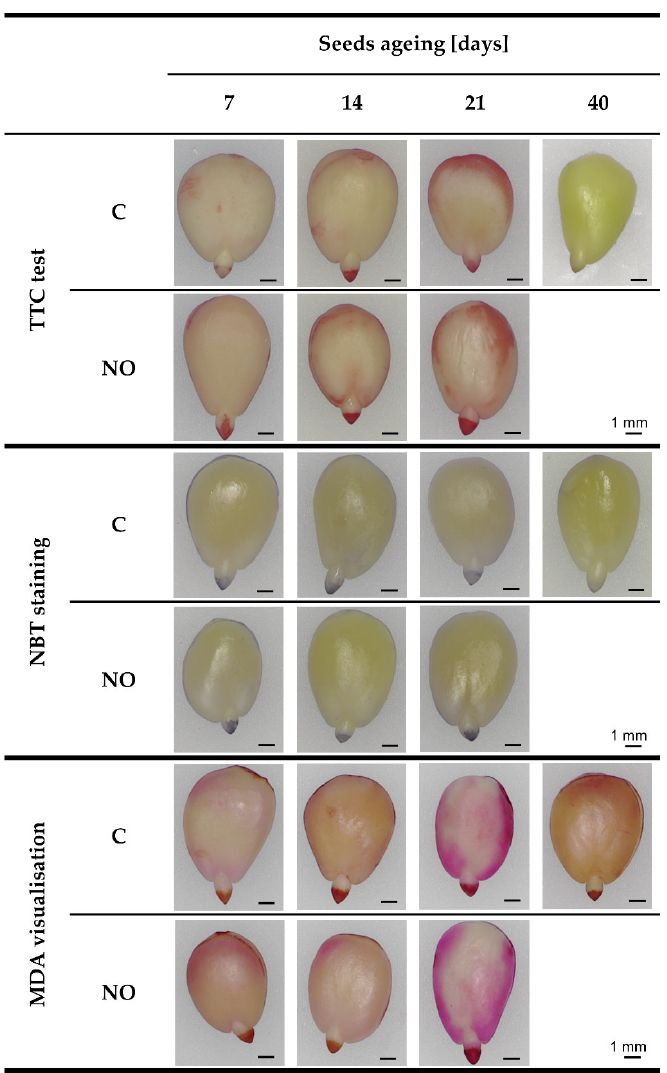
Figure 5. Visualization of staining of apple embryos isolated from seeds subjected to accelerated ageing for 7, 14, 21 and 40 days (C) or embryos isolated from aged seeds and treated with NO (NO), presenting the embryos viability (TTC test), in situ O 2 •− (NBT staining) and MDA localisation. Pictures of representative embryos of 3–4 repetitions for each treatment were shown. Photos were taken using TAGARNO FHD